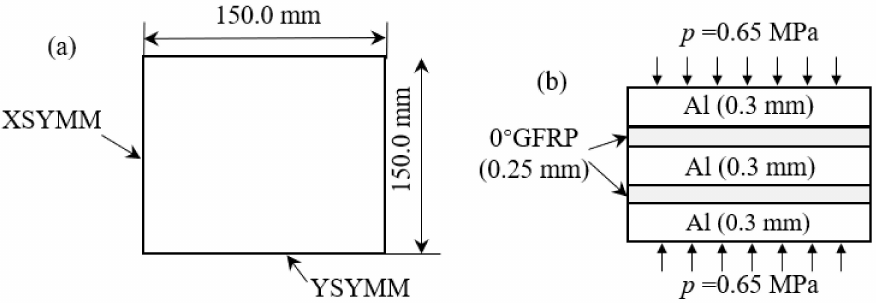
Figure 1. ( a ) Dimension and constraints of GLARE laminate; ( b ) Stacking sequence and load on